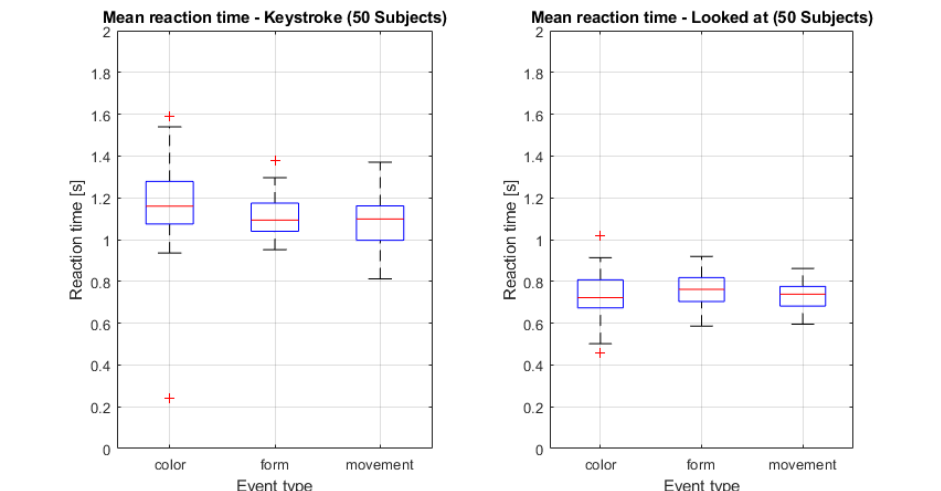
Figure 14: Boxplot of the measured reaction times for the identification of the three different object changes. The plot on the left visualizes the time needed between start of an object change and confirmation of its perception by button press. The plot on the right shows the time required to look at a changing